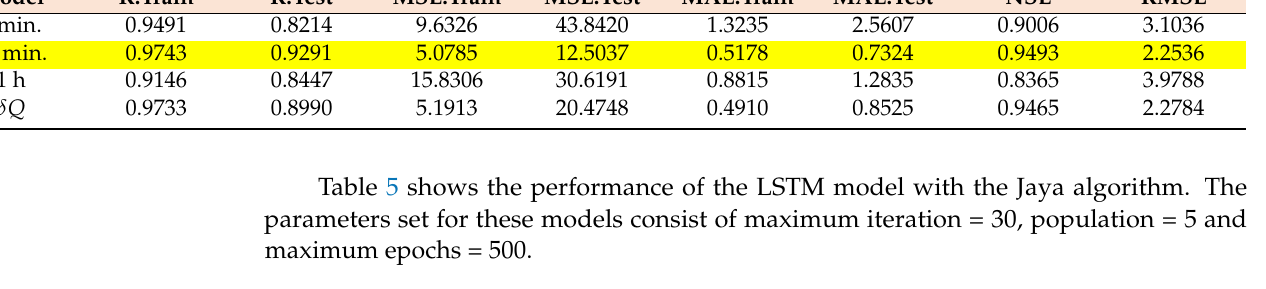
Table 5. Performance of LSTM with Jaya algorithm models for streamflow